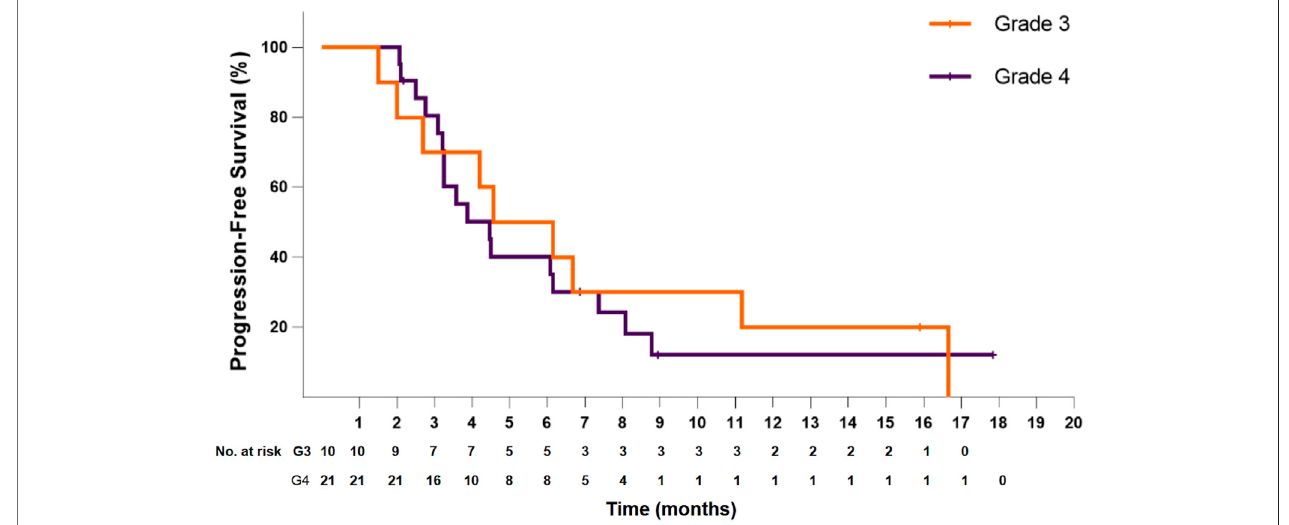
FIGURE 3 | Kaplan – Meier plot of progression-free survival for patients with grade 3 (orange) or grade 4 (violet) disease.